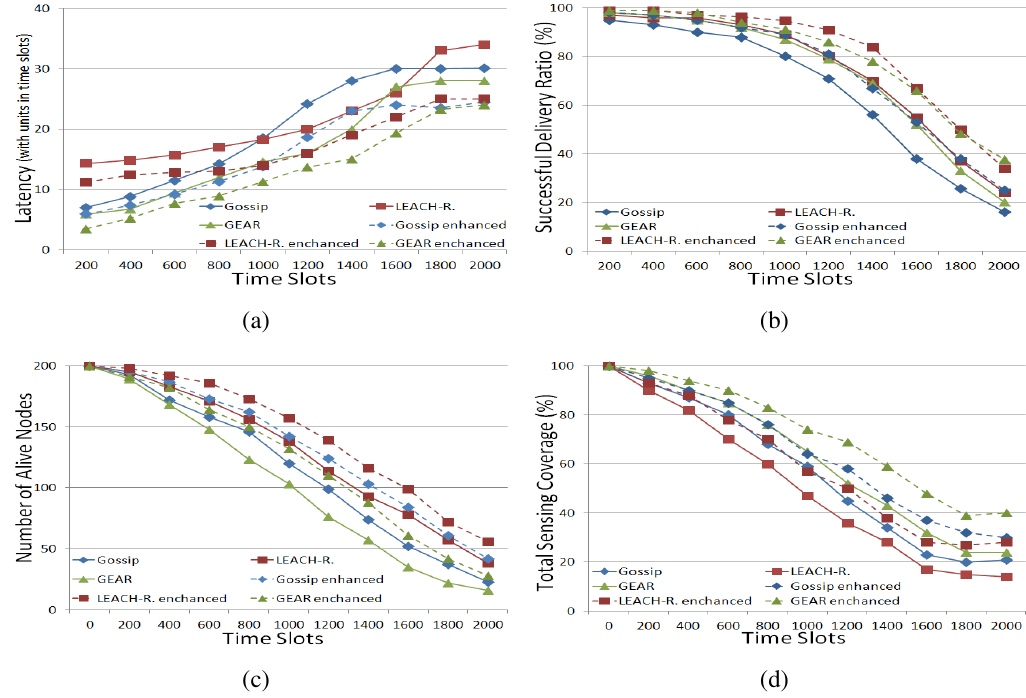
Figure 3. Performance of routing approaches in a dynamic WSN. ( a ) Average delivery latency; ( b ) successful delivery ration (%); ( c ) number of live nodes; ( d ) total sensing coverage